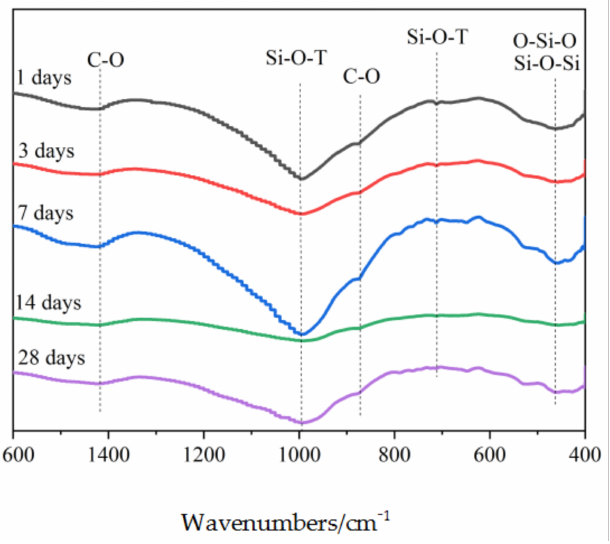
Figure 10. FTIR of CPB samples with the optimal mix ratios at different